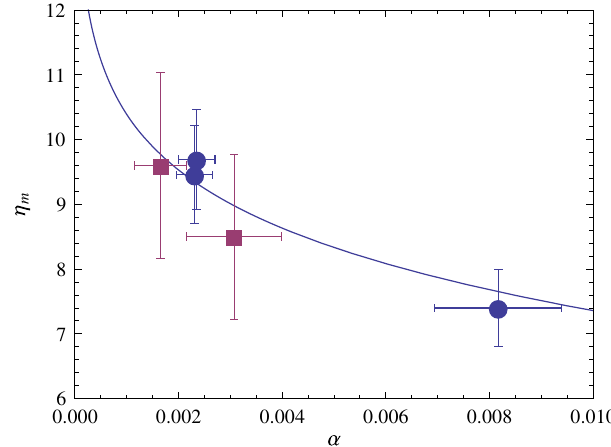
FIG. 2. “ Magic ” η as a function of the dimensionless parameter m α ¼ N ð ℏ ¯ ω =k T Þ 3 ð 1 − e − 4 η (cid:1) Þ (solid line). The blue solid circles B correspond to the results obtained for 133 Cs in Fig. 1(a) with η ¼ 0 . 098 . The red solid squares correspond to the 7 Li data of (cid:1) Fig. 1(c) with η ¼ 0 . 21 [28]. Error bars are (cid:1)